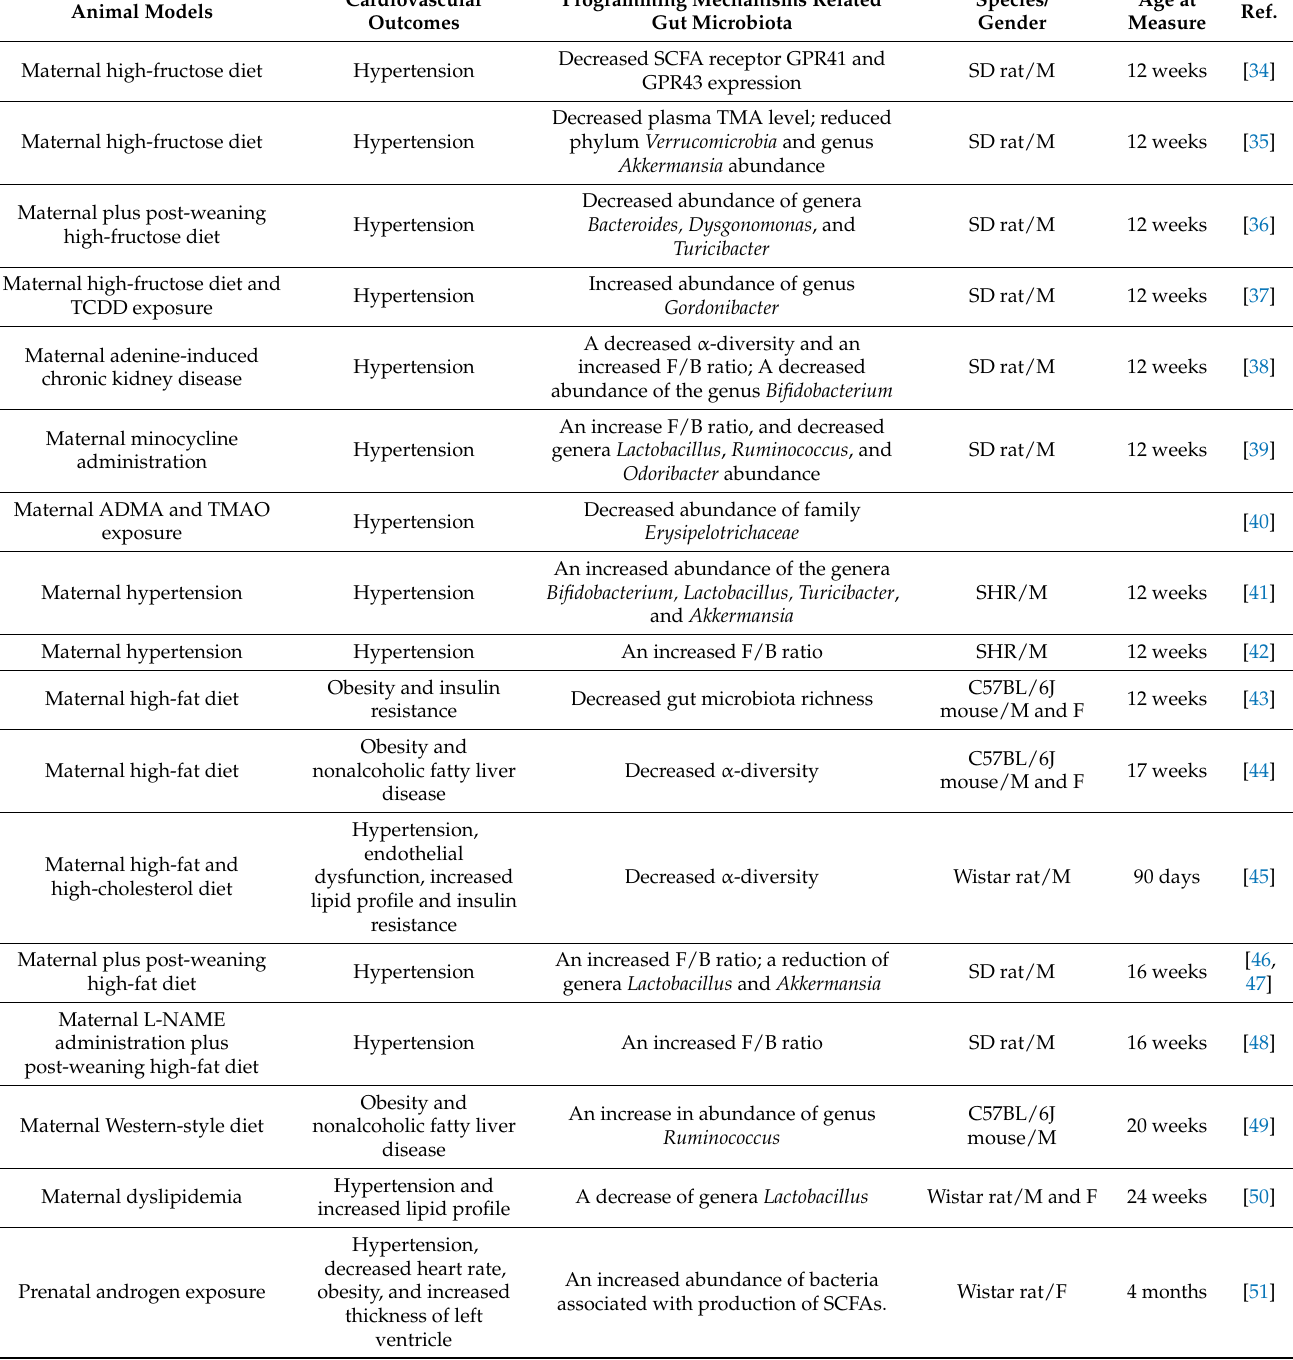
Table 1. Eligible animal models reporting cardiovascular outcomes related to alterations of gut